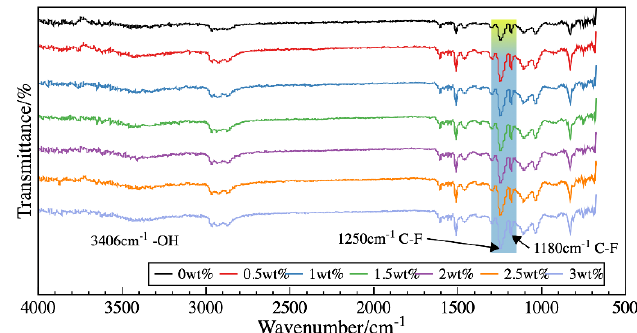
Figure 3. The FTIR spectra of the modified epoxy resin with mass fractions of FAS-17 of 0, 0.5, 1, 1.5, 2, 2.5, and 3 wt %.